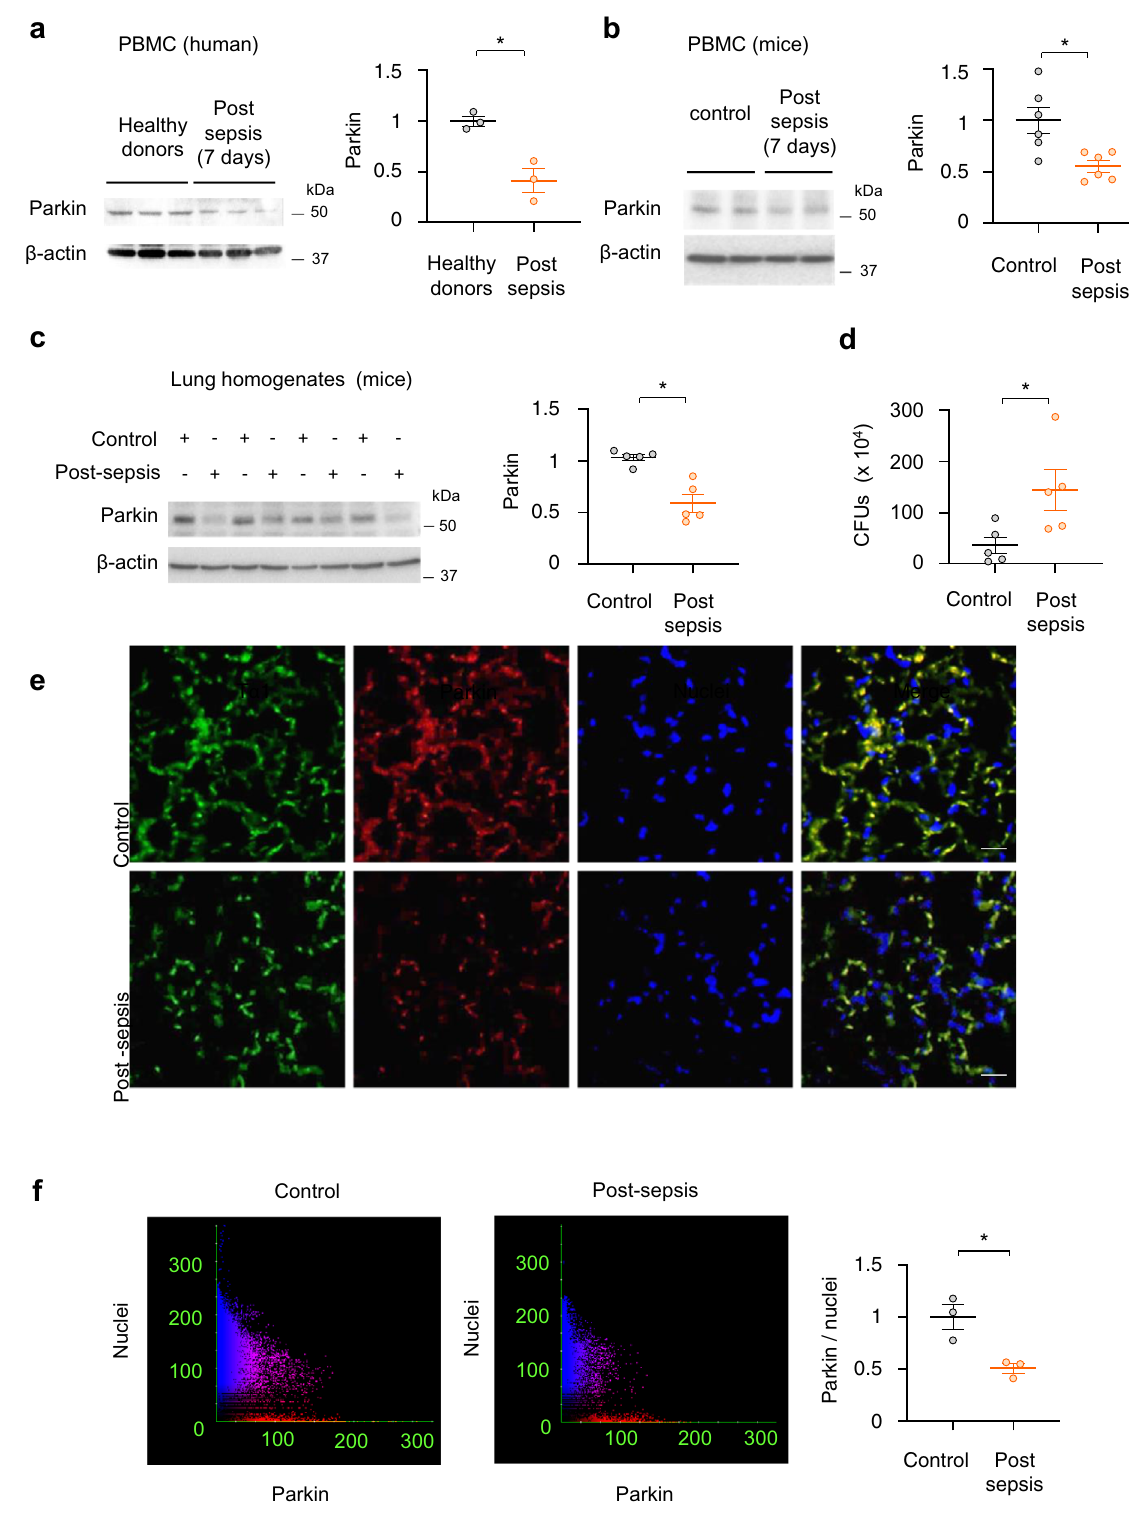
Figure 1. Parkin protein is diminished in leukocytes from sepsis survivors and post-sepsis mice. ( a – c ) Representative Western blots and quantitative analysis of Parkin in PBMCs from; ( a ) healthy donors or sepsis survivors, ( b ) control vs. post-septic mice, i.e. 7 days after CLP, and ( c ) whole lung homogenates in post-sepsis mice (24 h after CLP). Data presented as mean ± s.e.m., n = 3 (human) or n = 5–6 (mice). * P < 0.05, Student’s t -test. ( d ) The amount of bacteria (CFUs) in lung homogenates from control and post-CLP (7 days) mice. ( e ) Representative images show Parkin immunofluorescence in alveolar epithelial cells in lung sections from indicated groups of mice. T1-α (green), Parkin (red), nuclei (blue). Scale bar 100 µm. ( f ) Representative Scattergrams and quantitative analysis of Parkin/nuclei fluorescence intensity in lung sections of control and 24 h after CLP. Mean ± s.e.m., n = 3 mice/group. * P < 0.05, Student’s t